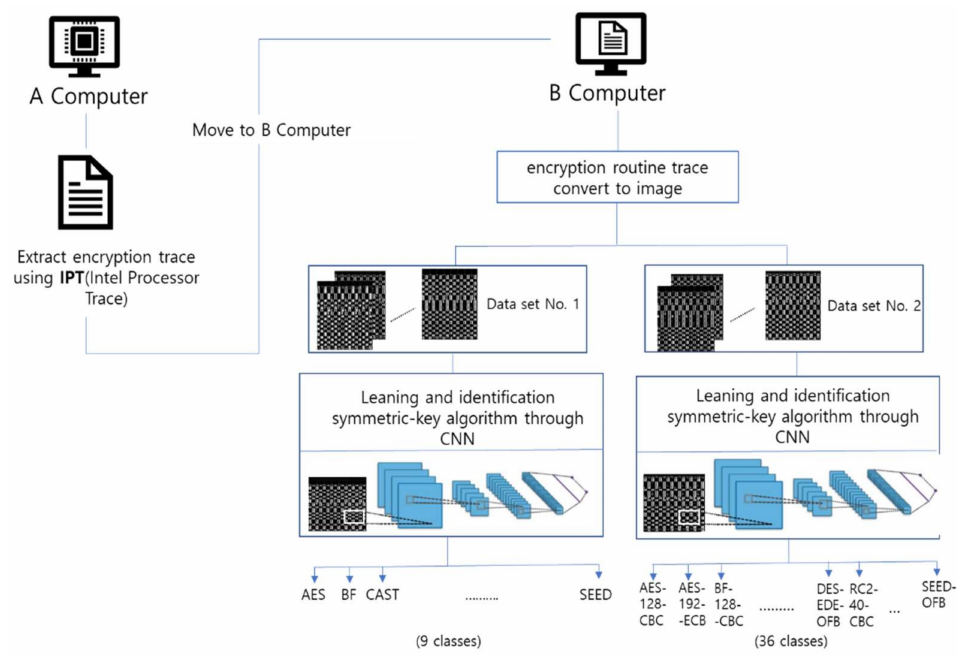
Figure 5. Overview of the proposed